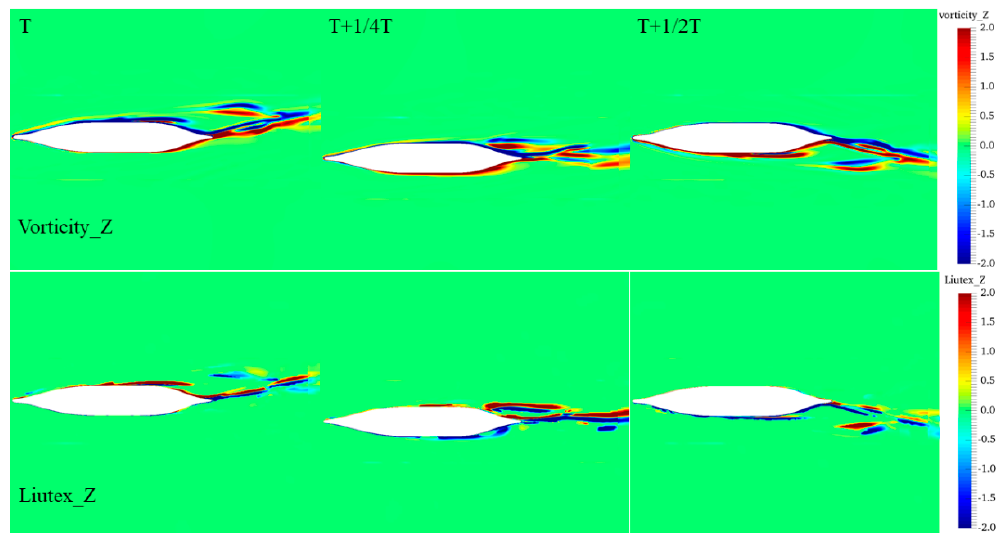
Figure 14. Vertical vorticity (top) and Liutex (bottom) at z / L pp = − 0.03572 in CASE PS8.